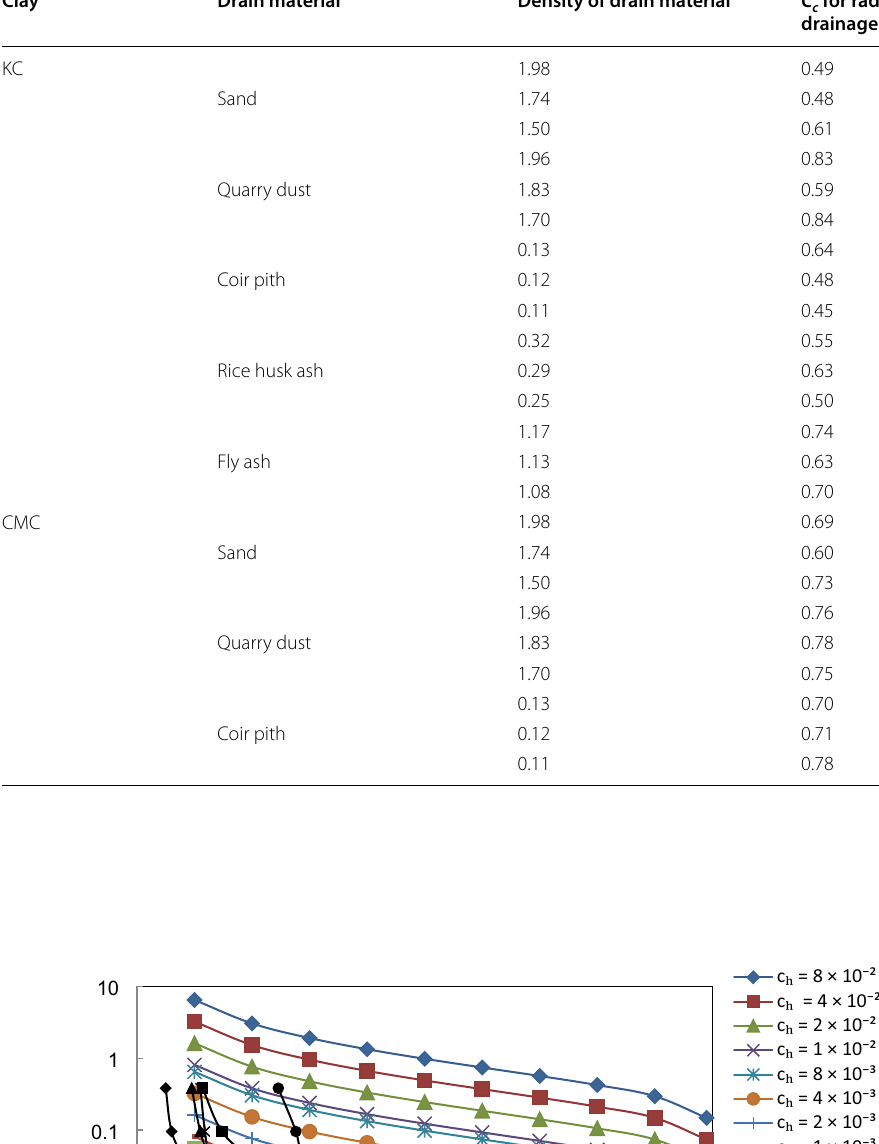
Table 3 C values for different drain materials used in the study c Clay Drain material Density of drain material KC